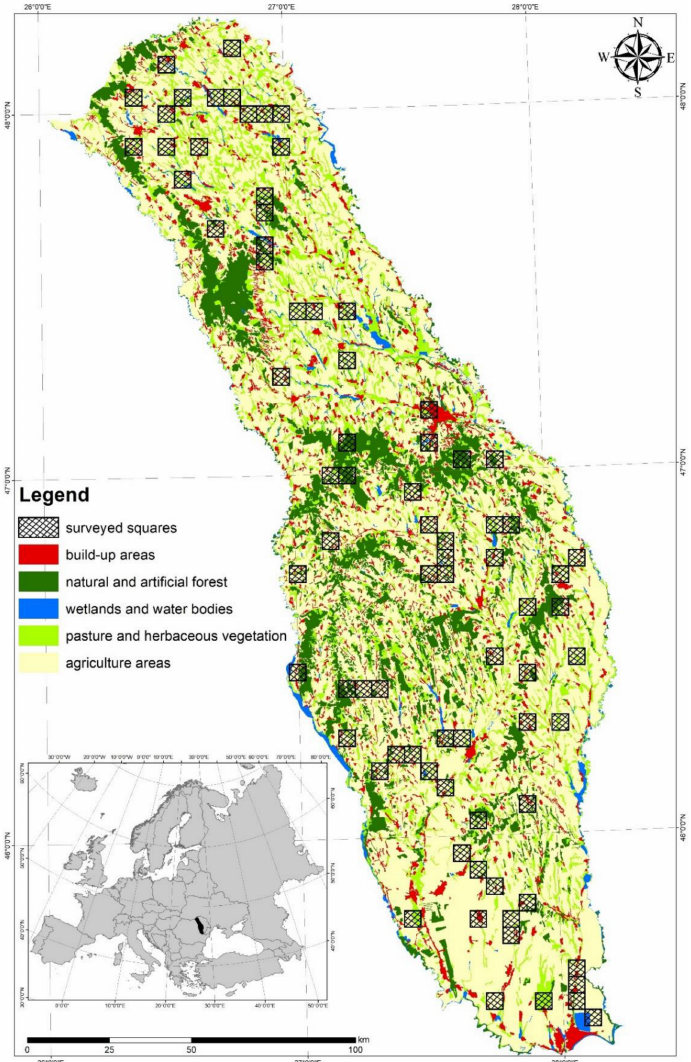
Figure 1. Study area location (marked with black on the small map) and the distribution of the surveyed squares in the natural and artificial mosaic habitats of our study area. Arable land, vineyards, fruit trees plantations, and agriculture mixed with significant natural vegetation became agriculture areas due to a low visibility on the map of the small plots for the last three habitat